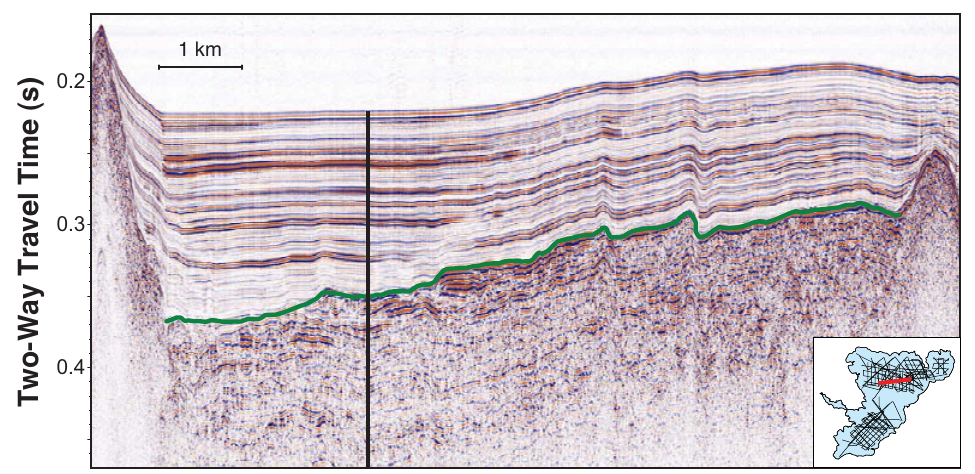
Figure 3. Example of seismic section from northern Lake Towuti (Wattrus et al, unpublished). Inset at bottom right indicates the location of this section (thick red line) within our seismic reflection grid (thin black lines). The boundary between stratified lacustrine sediment (upper unit) and fluviolacustrine sediment (lower unit) is marked by a green line. One hypothetical drilling target is illustrated by the black line.